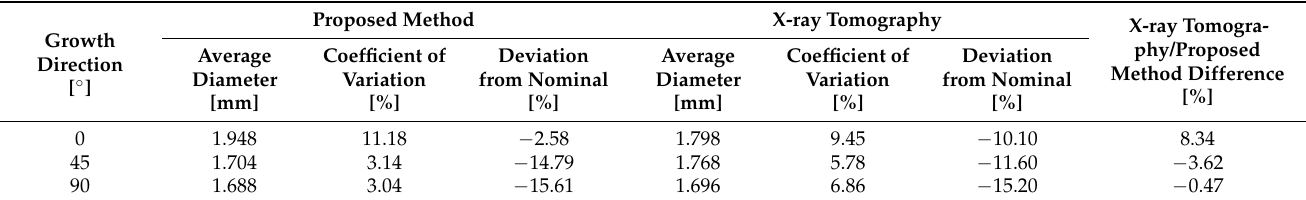
Table 1. Average diameter for the produced